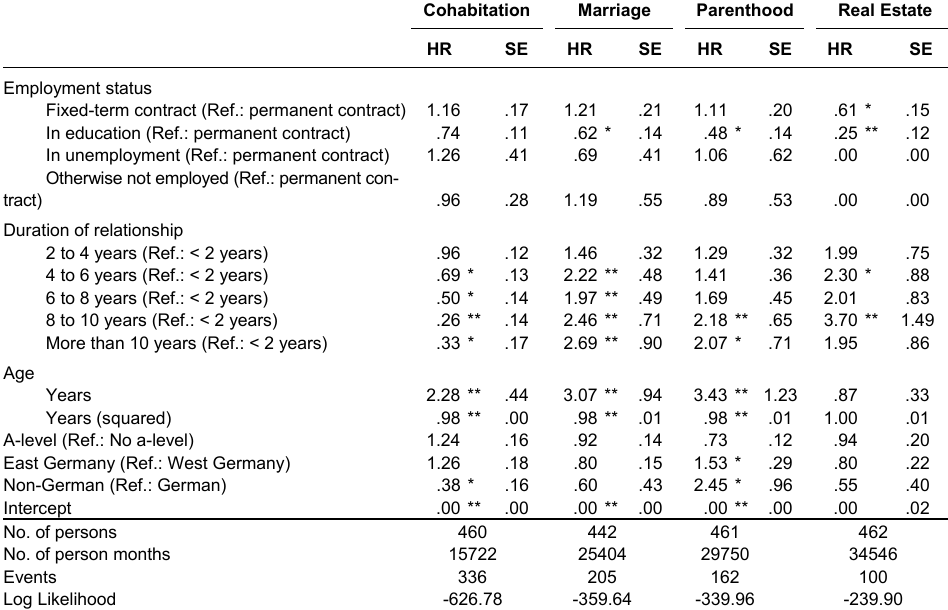
Table 4 : Effects of fixed-term employment on partnership events for men (piecewise-constant exponential models, hazard ratios and standard errors) Cohabitation Marriage Parenthood Real